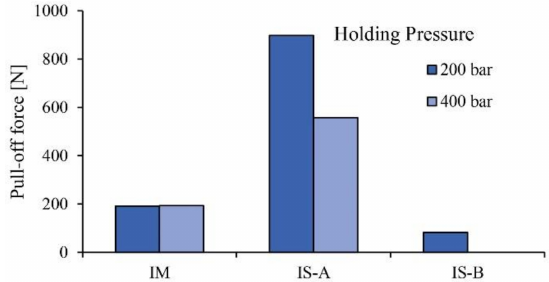
Figure 7. The pull-off force for the three different plates (IM—injection-molded plates; IS-A—magnesium catalyst-based in situ polymerization plates; IS-B—Brüggemann AP-NYLON-based in situ polymerization plates).